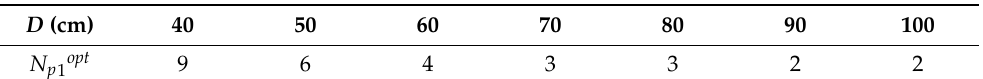
Table 3. Optimal number of turns of the Tx transformer’s primary coil when the load coil is fixed (Case 3 in Figure 12).